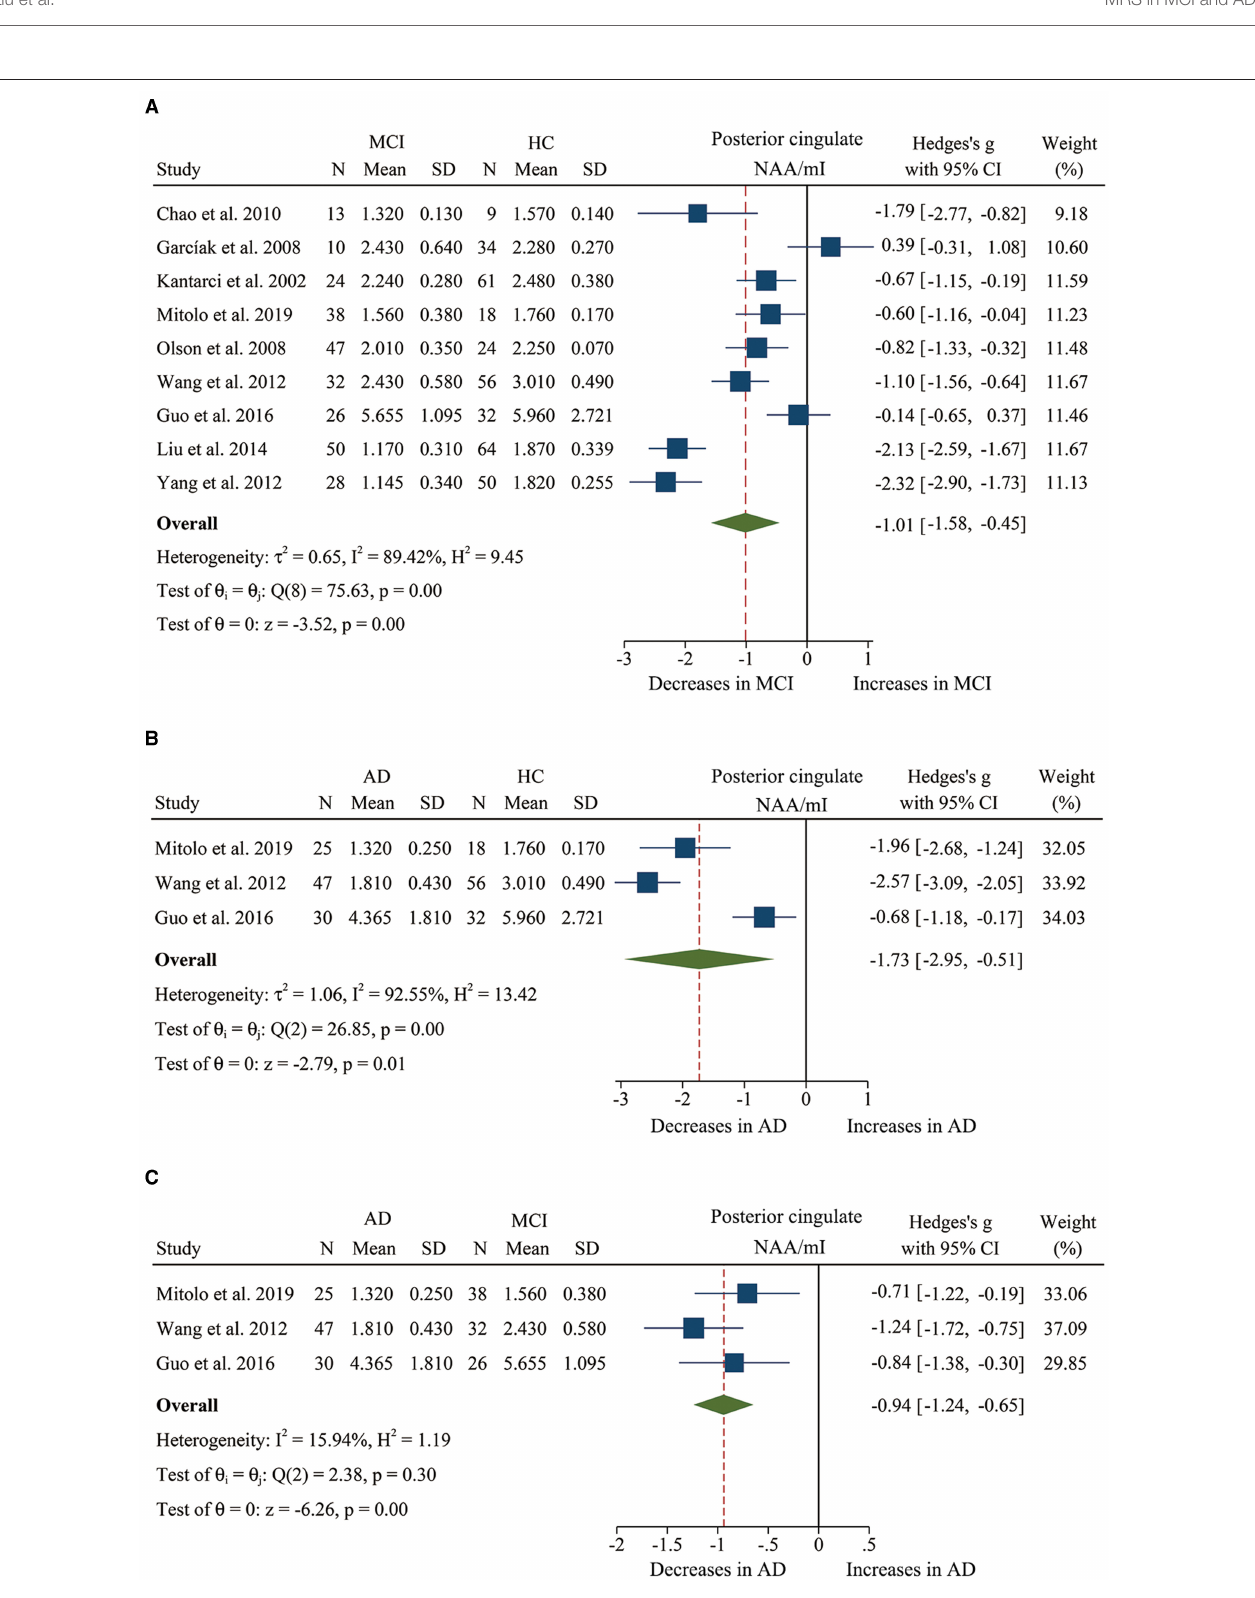
FIGURE 4 | Forest plots show the change of the ratio of NAA/mI in the posterior cingulate between MCI, AD patients, and HC subjects. (A) Data include 616 individuals from 9 studies for meta-analysis of NAA/mI levels between MCI and HC. (B) Data include 208 individuals from 3 studies for meta-analysis of NAA/mI levels between AD and HC. (C) Data include 198 individuals from 3 studies for meta-analysis of NAA/mI levels between AD and MCI.